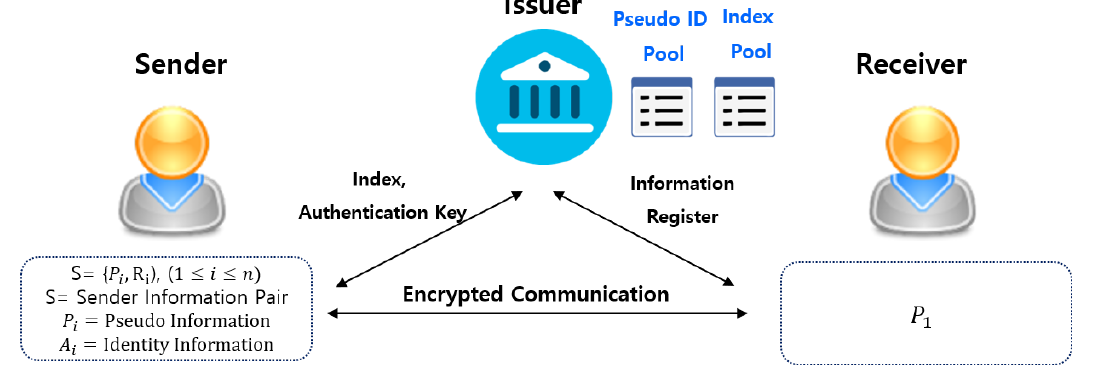
Figure 1. Diagram of the anonymous credential